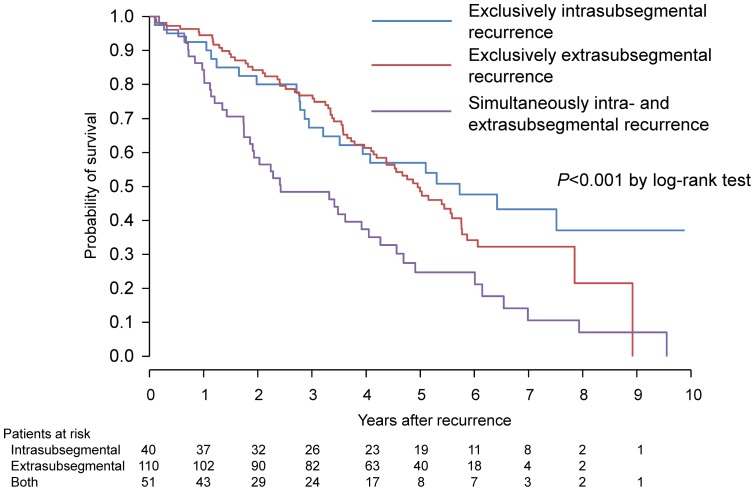
Cumulative survival probability after the diagnosis of recurrence according to the mode of recurrence.